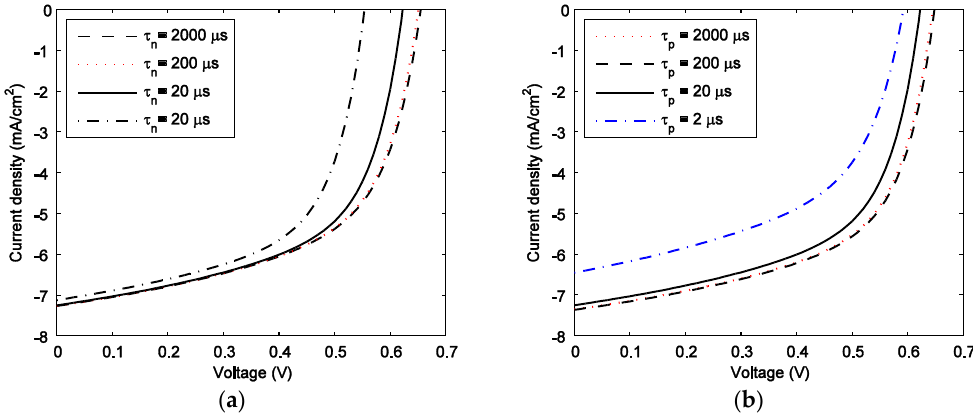
Figure 10. Theoretical current-voltage characteristics of P3HT:PCBM solar cells for ( a ) varying electron lifetimes with p = 20 s and ( b ) varying hole lifetime with n = 20 s. Carrier mobilities are: µ p = 2 × 10 −4 cm 2 /Vs and µ n = 2 × 10 −3 cm 2 /Vs.